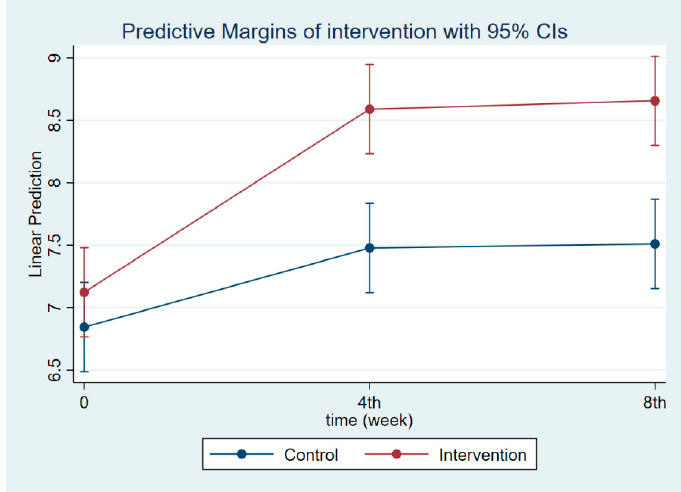
Figure 6. Maternal practice regarding CDM at follow-ups 1 and 2.